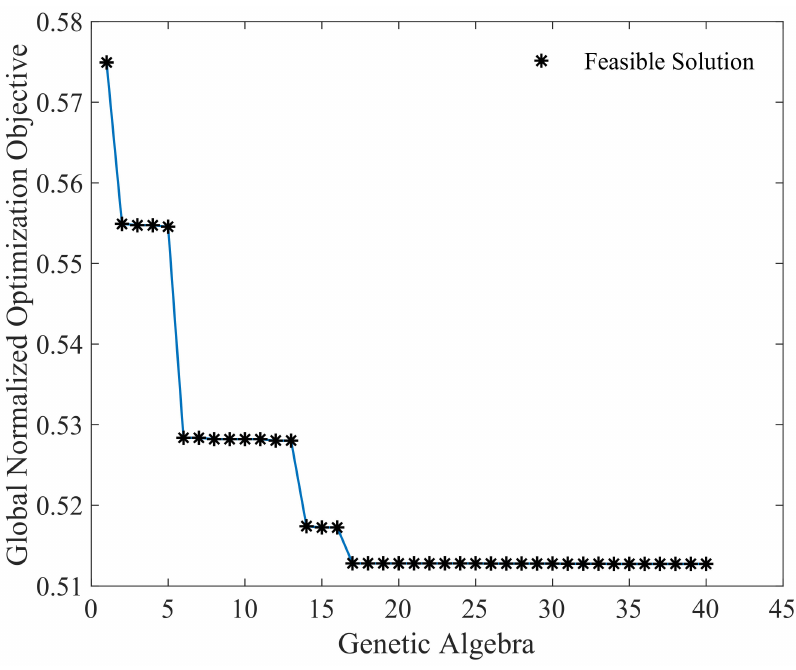
Figure 24. Iterative results of